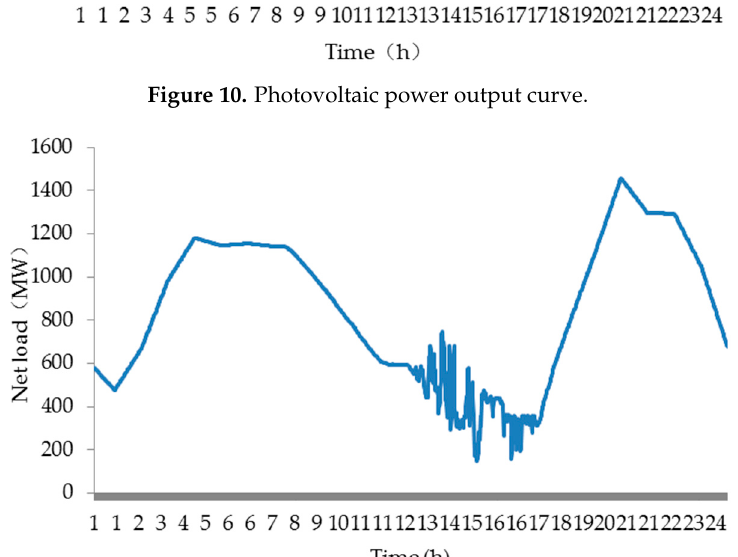
Figure 11. Net load curve.